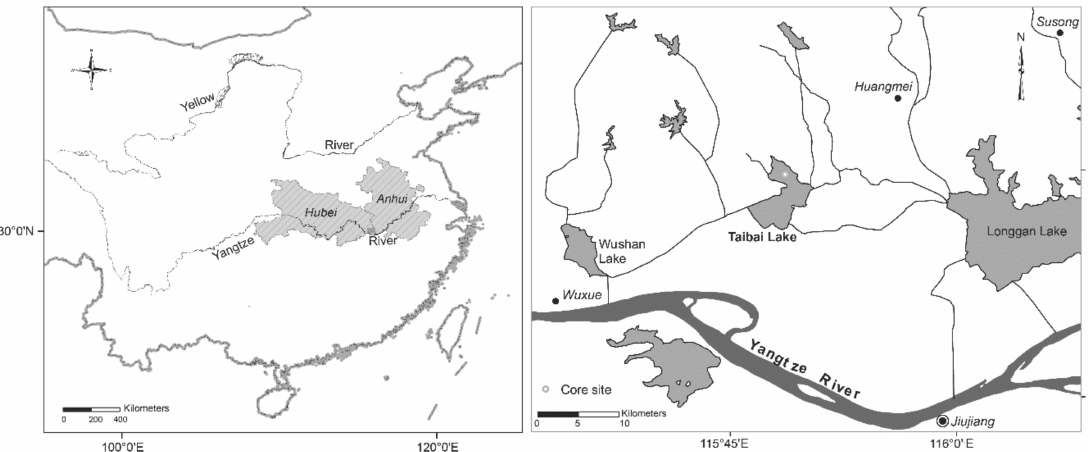
Figure 2. Map of Taibai Lake catchment in MLYB. Left-hand map shows the middle-lower reach of Yangtze River in China, between Hubei and Anhui province (green shadow), and the location of Taibai Lake catchment (orange square). The right-hand map shows the northern central coring site in Taibai, northern reservoirs draining into the lake, and connecting rivers/canals with other lakes and the Yangtze River.